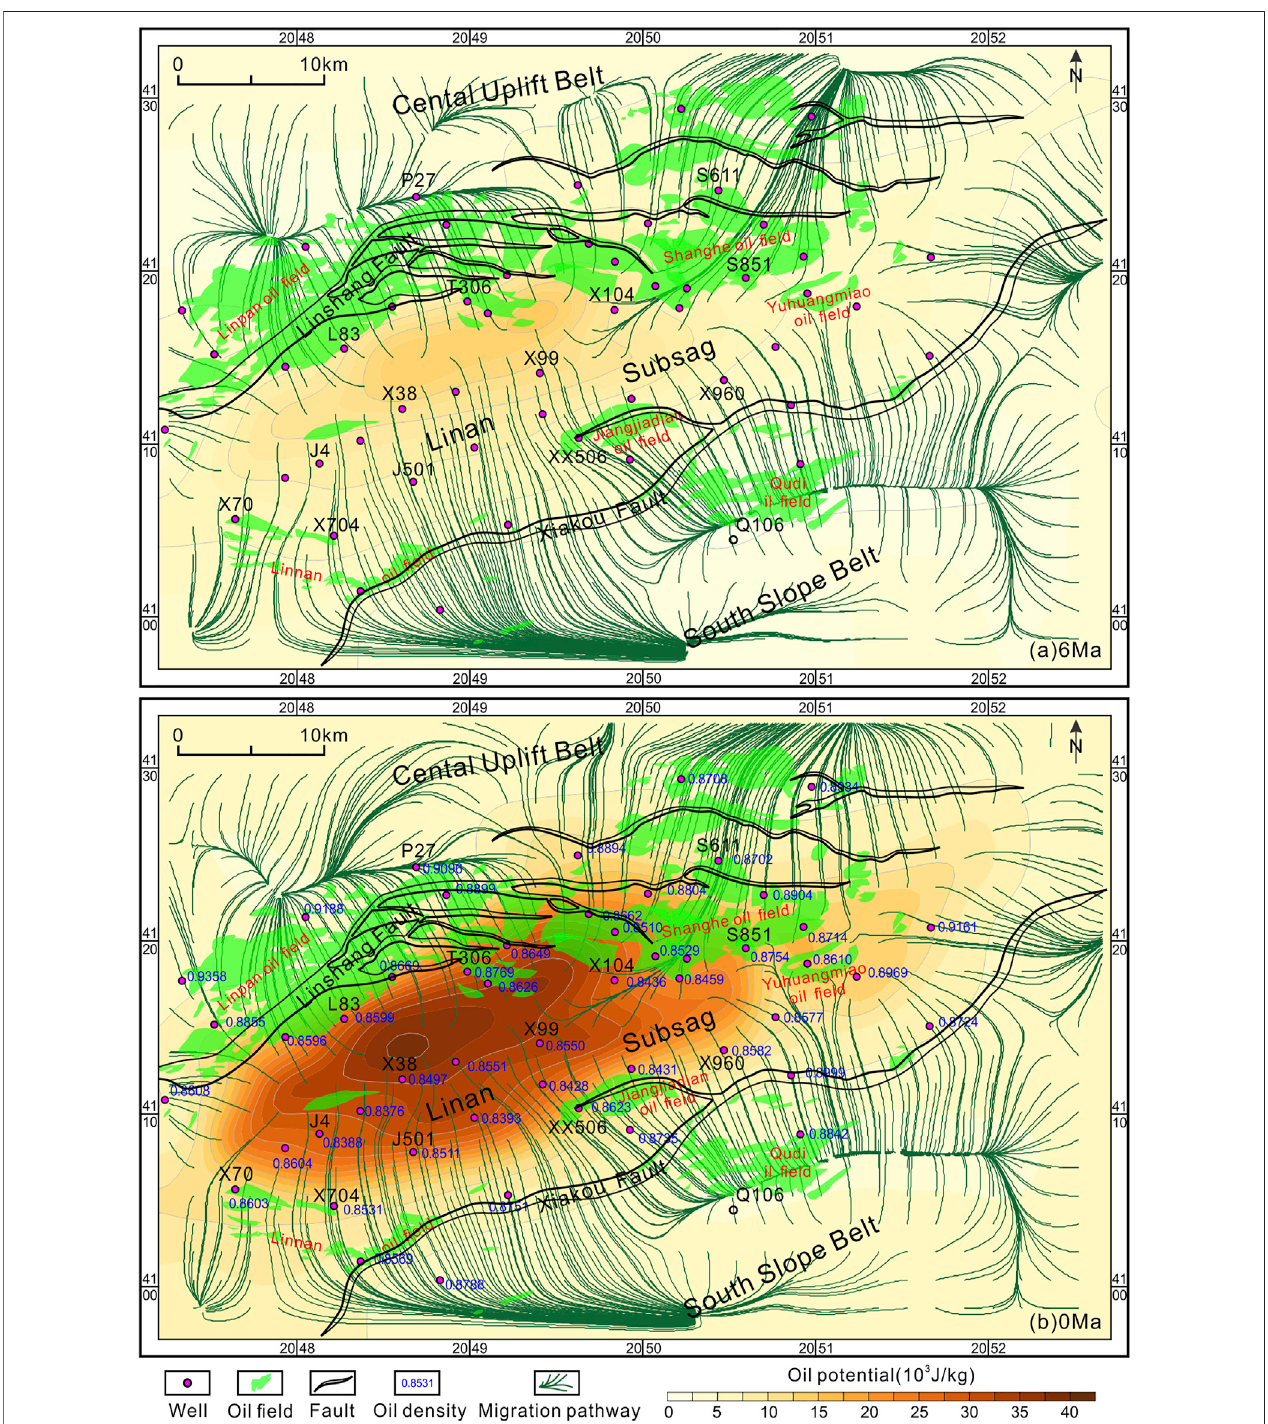
FIGURE15| Oilpotentialat themainoilaccumulationperiod of (A) 6 Maand (B) 0 MaintheEs3lcarrier bed.Themodeledoilmigrationpathways and locationsof oil fi eld in the Linnan Sag are also superposed.